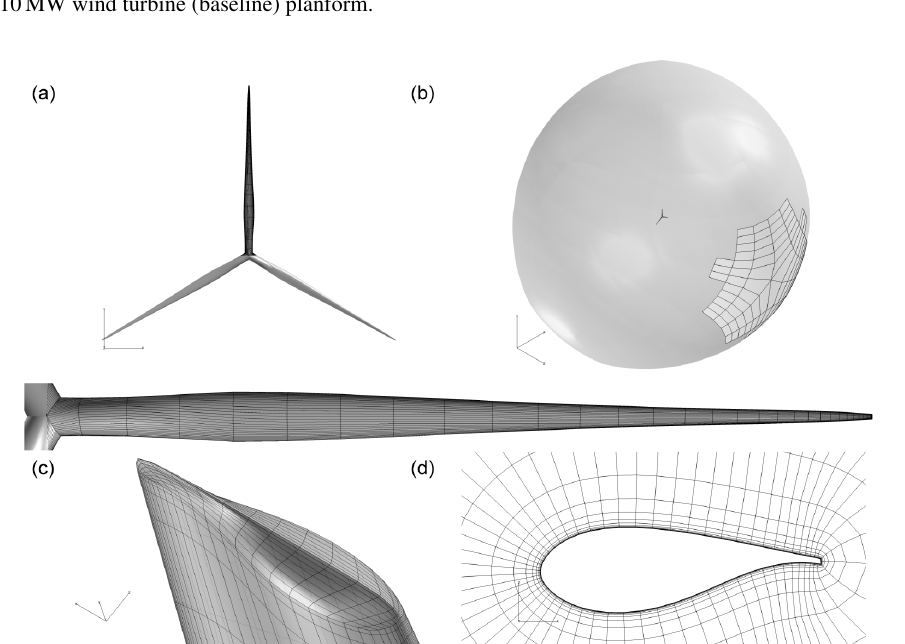
Figure 3. Surface (a) and volume (b) for which a close-up of one of the blade meshes is given below. Visualization of tip cap mesh (c) and a view of the airfoil discretization (d) are also offered. Notice that for clarity only one out of four mesh lines is shown. Boundary condition zones for inflow (transparent gray) and outflow (gray with black mesh lines) are visualized in the upper-right